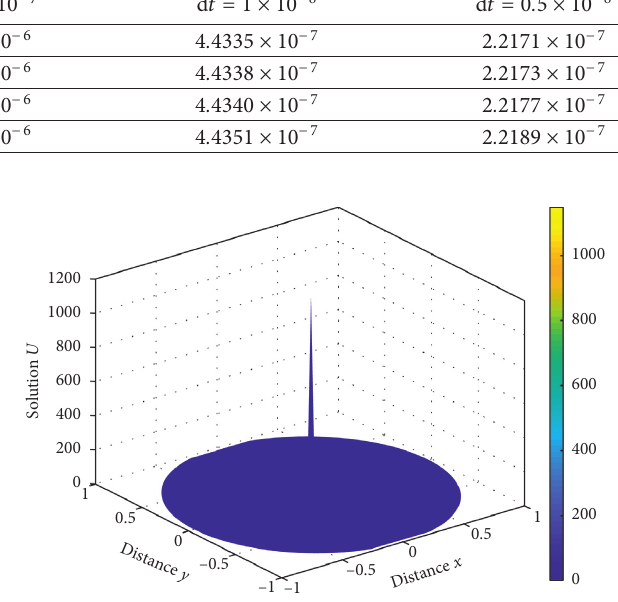
Table 7: Errors obtained for the present method with N � 200 at different final times for the heat transfer problem. Iterations